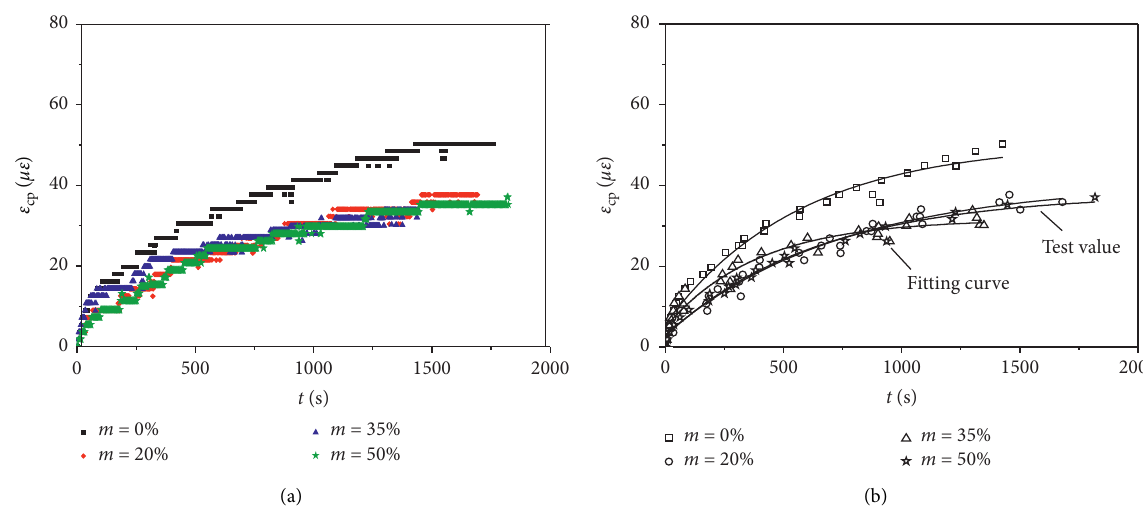
Figure 7: Experimental and fitted creep-stain curves of concrete with various fly ash replacement ratios ( m ) during the decelerating creep stage.